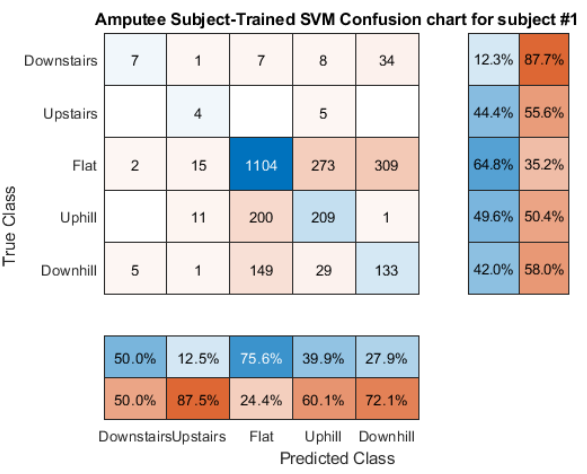
Figure A10. Support Vector Machine Confusion Chart for ILLA participant A4 as trained by healthy individuals.